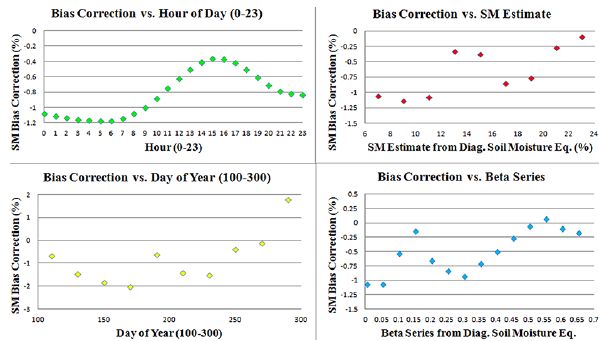
Figure 7. Bias correction analysis, SCAN site 2015 (IAQ, desert, loamy sand).